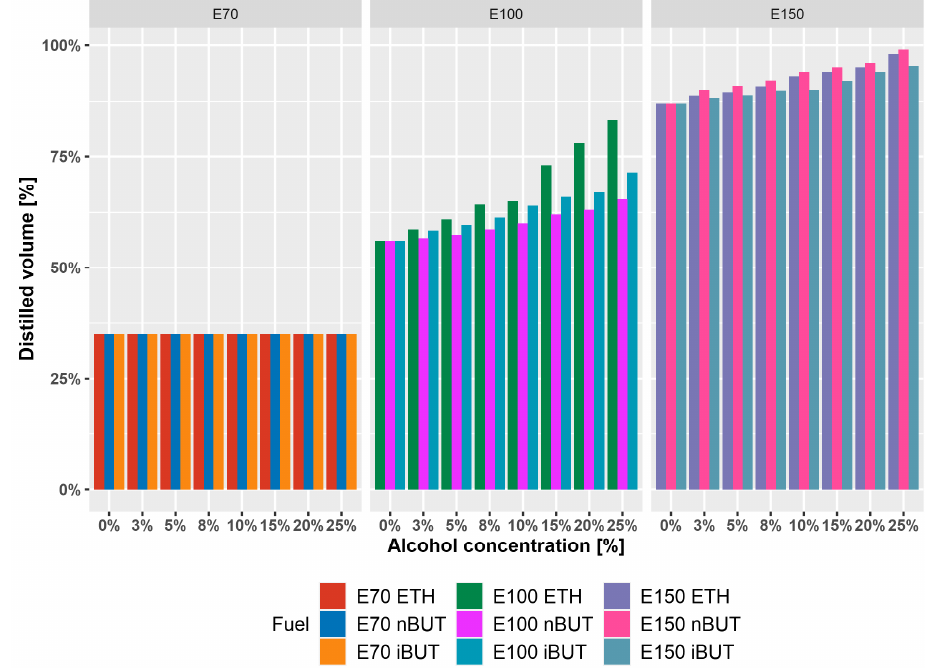
Figure 3. Influence of alcohol content on E70, E100, and E150 of alcohol-gasoline mixture. mixtures. These ethers also affect the shape of the distillation curve and they are well recognizable. Ethers affect the middle part of the distillation curve most—around 10–85%. In the case of the combination of 5% (V/V) ethanol and 5% (V/V) ETBE, the effects of these